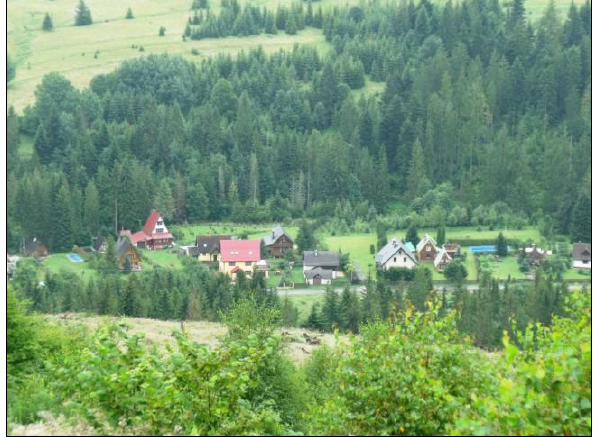
Fig. 7. Beskid Sports Arena ski resort in Szczyrk (Silesian Beskids)